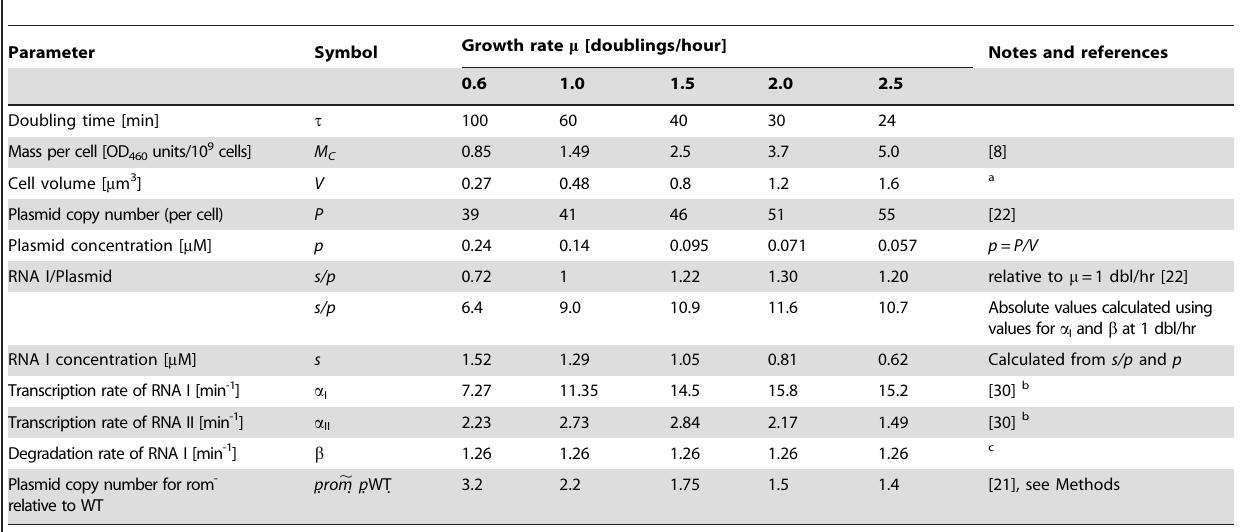
Table 1. Growth-rate dependence of parameters related to plasmid copy number control.